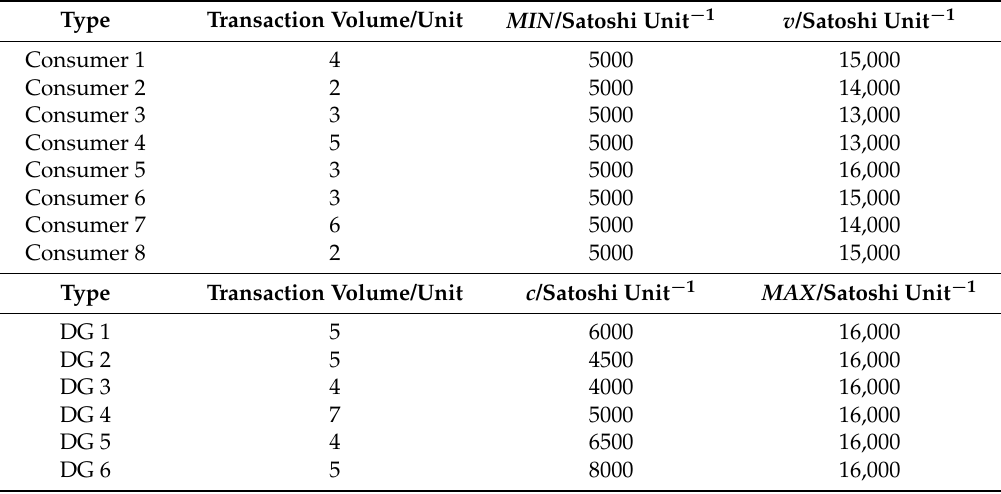
Table 1. Transaction parameters of consumers and